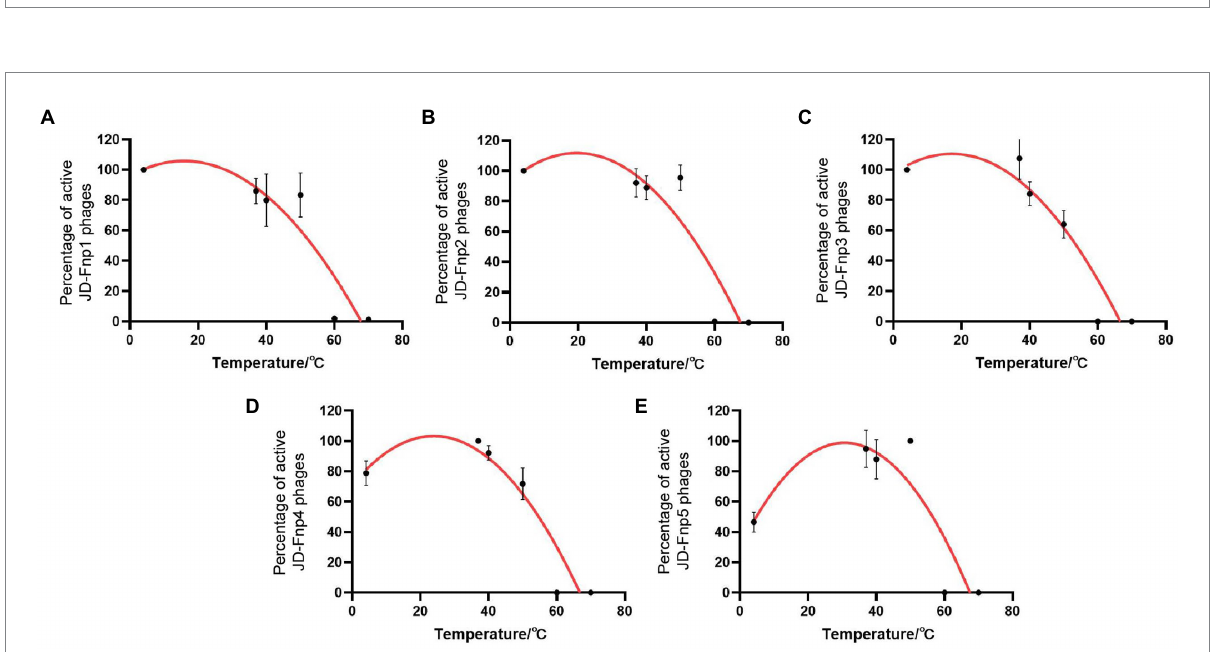
FIGURE 4 Thermal stability of phages JD-Fnp1 ~ JD-Fnp5. (A) JD-Fnp1; (B) JD-Fnp2; (C) JD-Fnp3; (D) JD-Fnp4; (E) JD-Fnp5. The x-axis represents temperature range; the y-axis represents the relative titer of JD-Fnp phage to the titer at 37 ° C or 4 ° C (The control temperature of JD-Fnp1 ~ JD- Fnp4 is 37 ° C, and the control temperature of JD-Fnp5 is 4 ° C that the phage has the best stability); Percentage of active JD-Fnp phages = (N/ N0) × 100, where N is the number of viable phages after 1 h of incubation and N0 was the initial number of phages. All experiments were repeated in